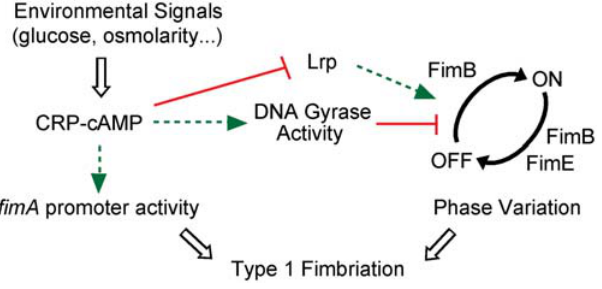
Figure 7. Schematic model of action of the CRP-cAMP complex on the regulation of type 1 fimbriation. The integration of different environmental signals modify the levels of the CRP-cAMP complex which affects the phase variation of type 1 fimbriae by altering the FimB-mediated directionality of the OFF to ON recombination event. Based on our results, a model is proposed where a stimulation of the DNA gyrase activity by CRP-cAMP [52] would repress the FimB- mediated recombination from the OFF to the ON orientation by a mechanism that requires the presence of Lrp [29]. In this work, a repressing effect of CRP-cAMP on the expression of Lrp and a stimulatory effect of CRP-cAMP on fimA promoter activity have also been described. Green arrows indicate stimulatory effects, whereas red lines indicate repressing effects.